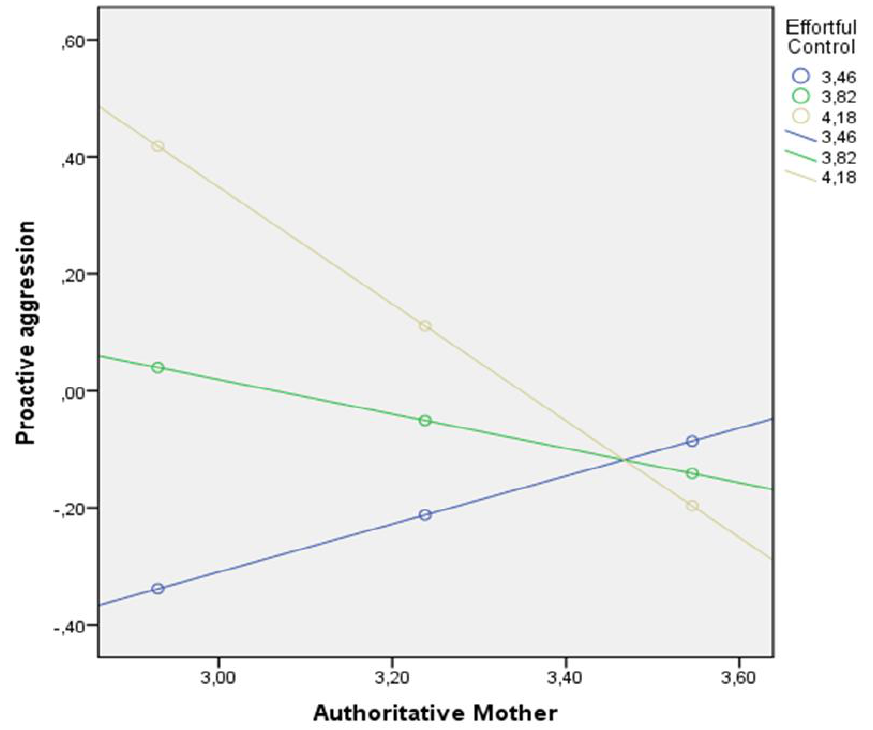
Figure 2. Interaction between behavioral inhibition and the mother’s authoritarian parenting style in relation to reactive aggression among boys.